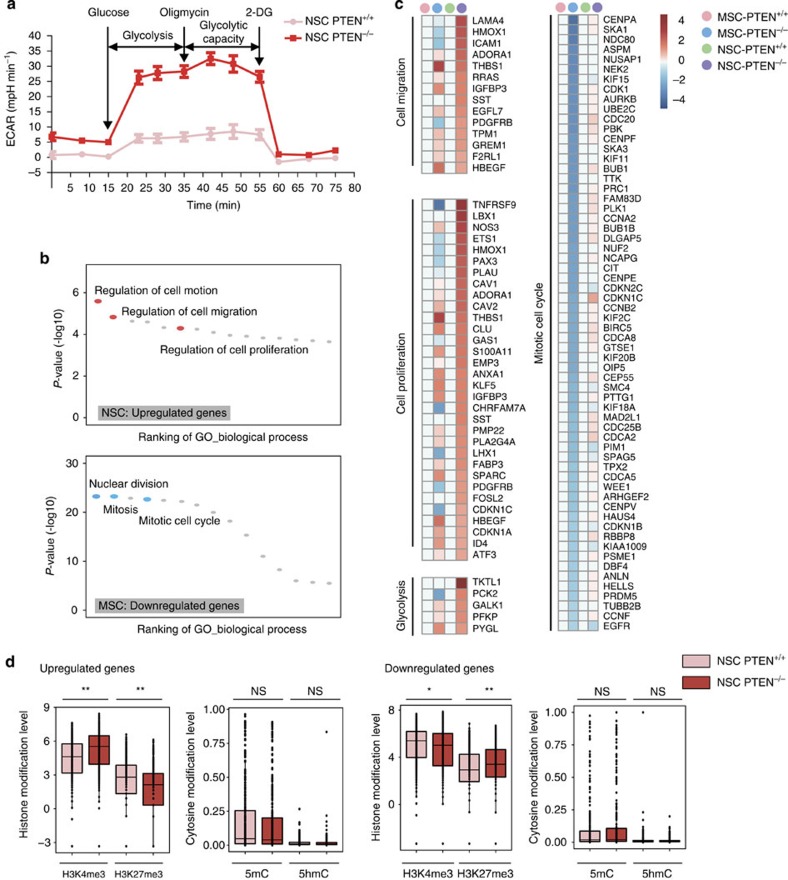
Transcriptome and epigenome analyses in PTEN-deficient stem cells.(a) Glycolysis flux analysis measured by extracellular acidification rates (ECARs) in PTEN+/+ and PTEN−/− NSCs. n=5. (b) GO biological process analysis of genes upregulated (q-value<0.05, FC[PTEN−/−/PTEN+/+]>2) after PTEN knockout in NSCs and genes downregulated (q-value<0.05, FC[PTEN−/−/PTEN+/+]<0.5) after PTEN knockout in MSCs. (c) Heat map displaying the upregulated genes (q-value<0.05, FC[PTEN−/−/PTEN+/+]>2) in PTEN-deficient NSCs (left) and the downregulated genes (q-value <0.05, FC[PTEN−/−/PTEN+/+]<0.5) in PTEN-deficient MSCs (right). The representative enriched GO terms of biological processes were shown at the left side of each panel. (d) Boxplots showing H3K4me3, H3K27me3, 5mC and 5hmC levels in the region of 1 kb upstream and 1 kb downstream of TSS of differentially expressed genes between PTEN−/− and WT NSCs including the upregulated genes (left panels, q-value<0.05, FC[PTEN−/−/PTEN+/+]>2; n=326) and downregulated genes (right panels, q-value <0.05, FC[PTEN−/−/PTEN+/+]<0.5; n=281). *P value <0.05 (Wilcoxon signed-rank test); **P value <0.01 (Wilcoxon signed-rank test); NS, not significant.